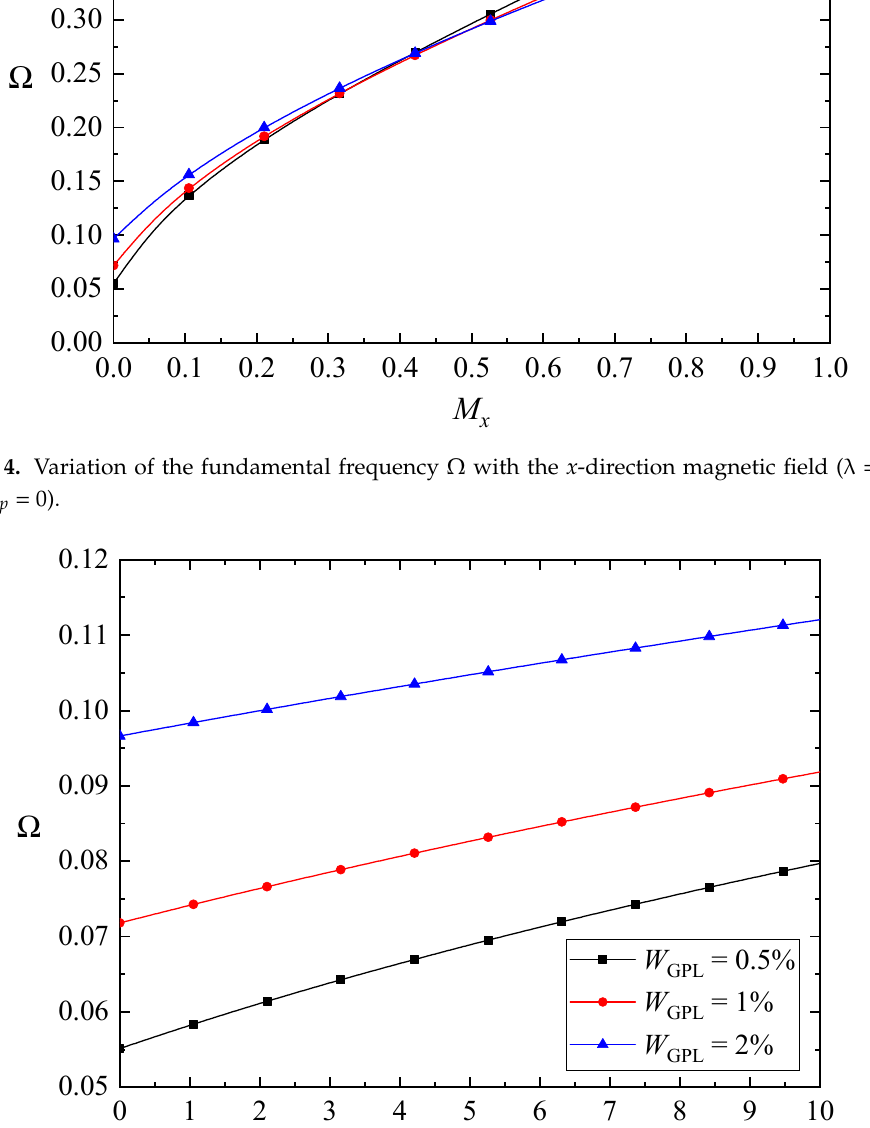
Ω with the y -direction magnetic field ( λ = 1/10, K w